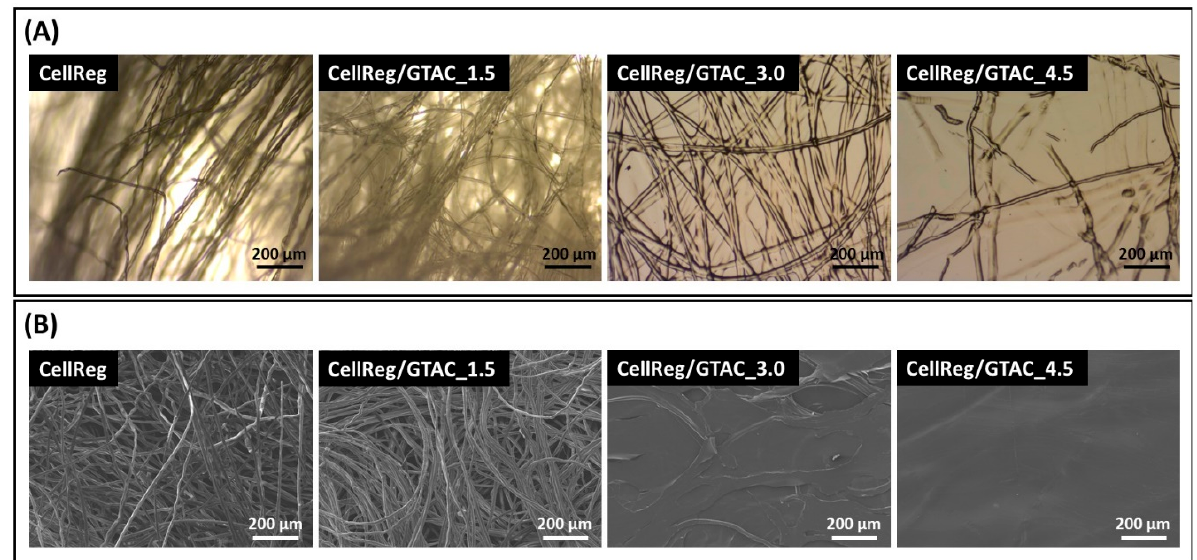
Figure 3. ( A ) Optical micrographs and ( B ) SEM micrographs of the non-modified and modified regenerated cellulose samples: CellReg, CellReg/GTAC_1.5, CellReg/GTAC_3.0 and CellReg/GTAC_4.5. The surface charge of the non-modified and modified regenerated cellulose samples